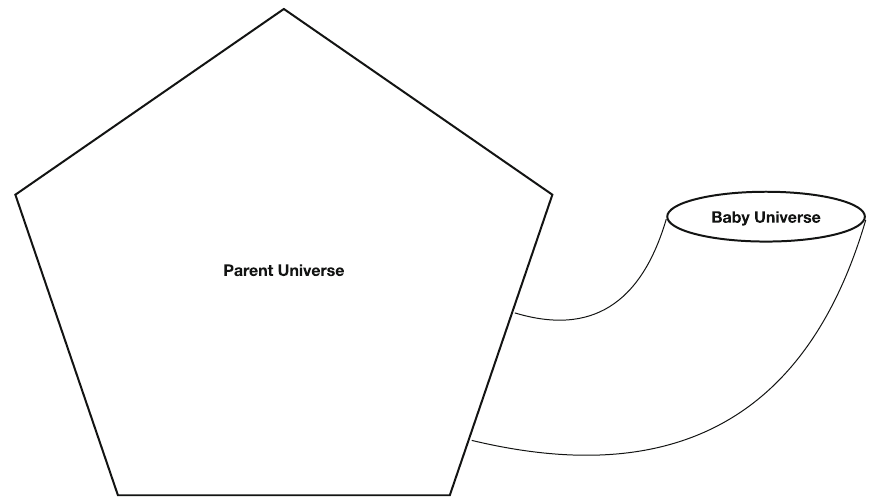
Fig. 2 A schematic cartoon of a baby Universe popping out of a parent